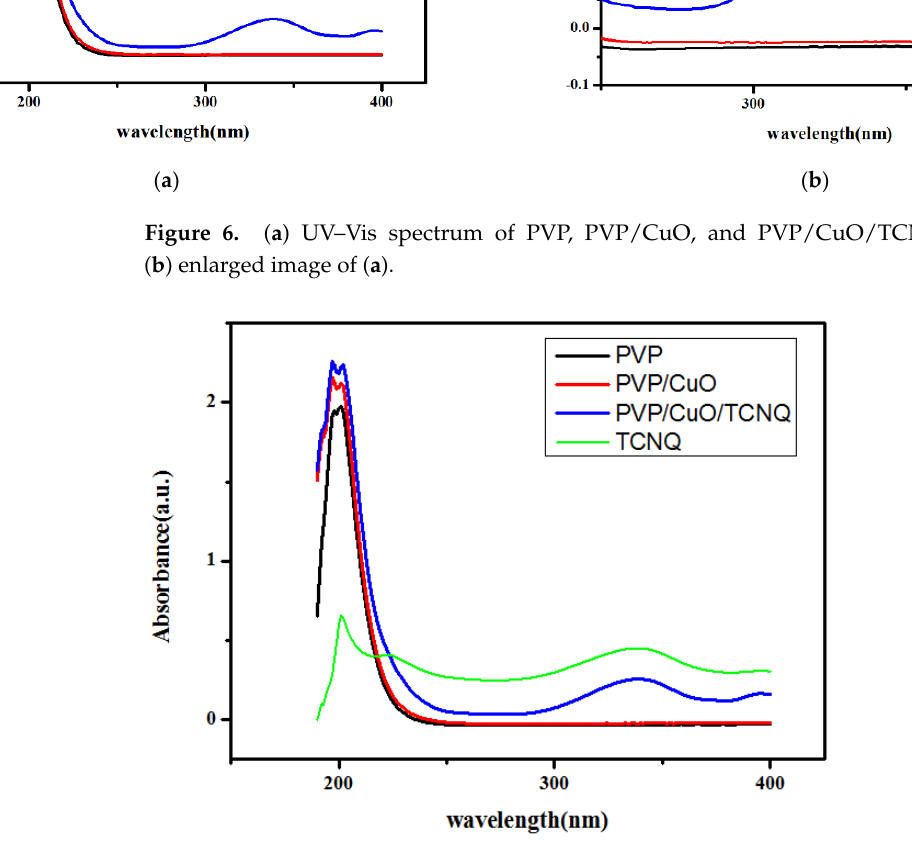
Figure 7. UV – Vis spectrum of PVP, TCNQ, PVP/CuO, and PVP/CuO/TCNQ composite.